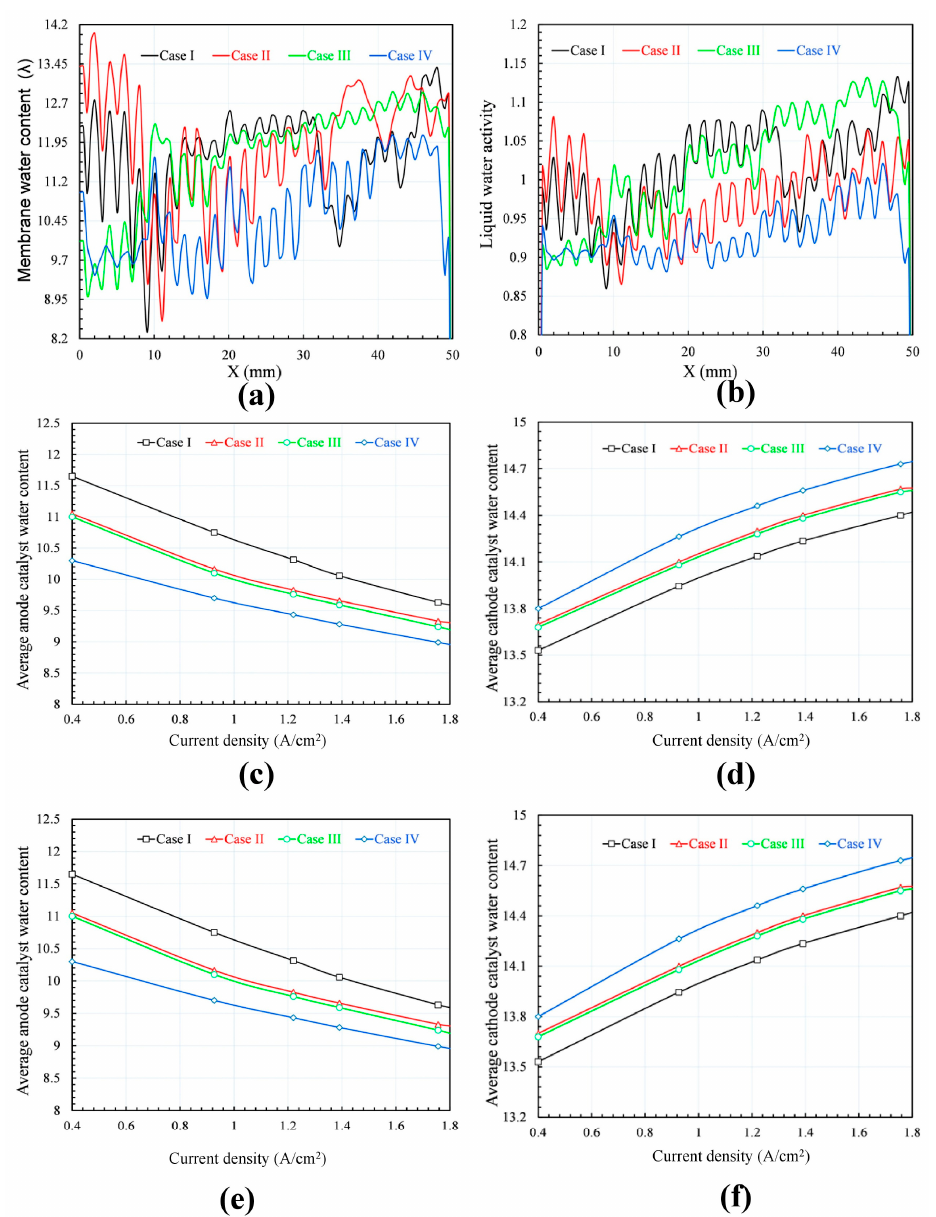
Figure 6. Comparisons of ( a ) membrane water contents along a reference location; ( b ) liquid water activities along a reference location; ( c ) average anode catalyst water contents; ( d ) average cathode catalyst water contents; ( e ) average membrane water contents; and ( f ) membrane protonic